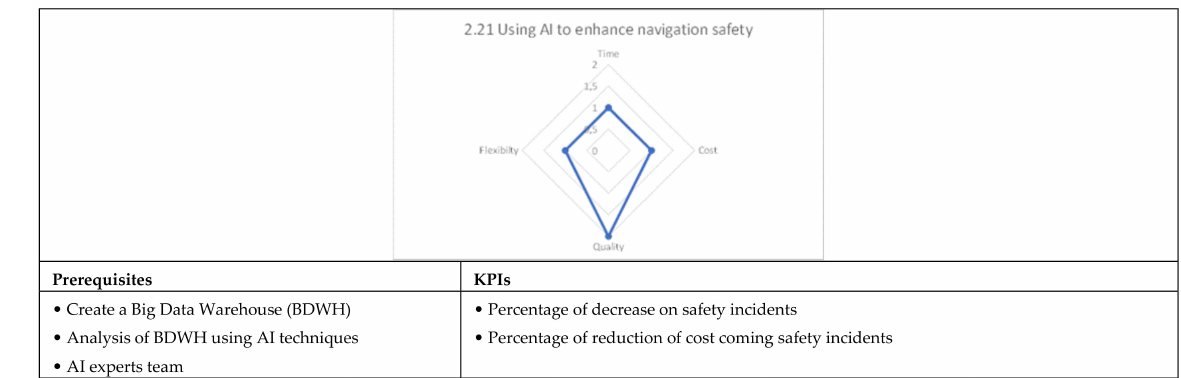
Figure A25. Using AI to enhance navigation safety data sheet.